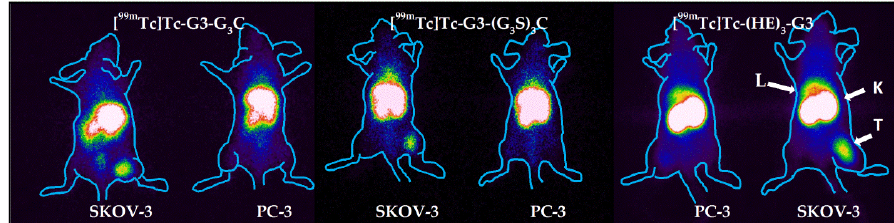
Figure 11. Gamma ‐ camera imaging of HER2 expression in Nu/J mice bearing SKOV ‐ 3 and PC ‐ 3 xenografts using of [ 99m Tc]Tc ‐ G3 ‐ G 3 C, [ 99m Tc]Tc ‐ G3 ‐ (G 3 S) 3 C, and [ 99m Tc]Tc ‐ (HE) 3 ‐ G3 4 h pi. (10 μ g, 8 MBq). L—liver, K—kidneys, T—tumor. Contours were derived from a digital photograph and superimposed over the images to facilitate interpretation.